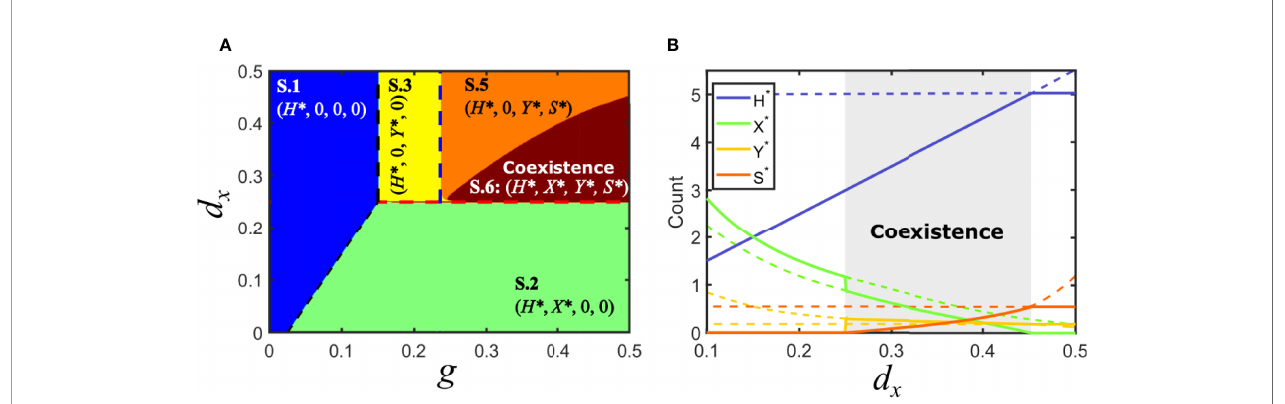
FIGURE 6 | Solutions for model S in parameter space: parasitic satellite. (A) Phase space of solutions in the plane { g , d x } for a parasitic satellite in the particular case F c < F y . A region of coexistence occupies part of the area where the virus y -satellite eliminated virus x if the satellite was commensal or mutualistic. (B) Bifurcation diagram of a cross-section of A, for g = 0.5. A region of co-existence of all the populations is shown in gray for 0.25 < d x <0.4529 , corresponding to solution S.6 . Solutions collide with the degenerated solution S.4 at d x = 0.25; a bifurcation occurs at d x = 0.4529A zoom of the region of coexistence for variables X *, Y * and S * can be found in the Supplementary Information . Parameters used d =0.05, p x =0.1, p y =0.1, d y =0.25, p s =0.8, p sy =0.04, d s =0.3, p − y